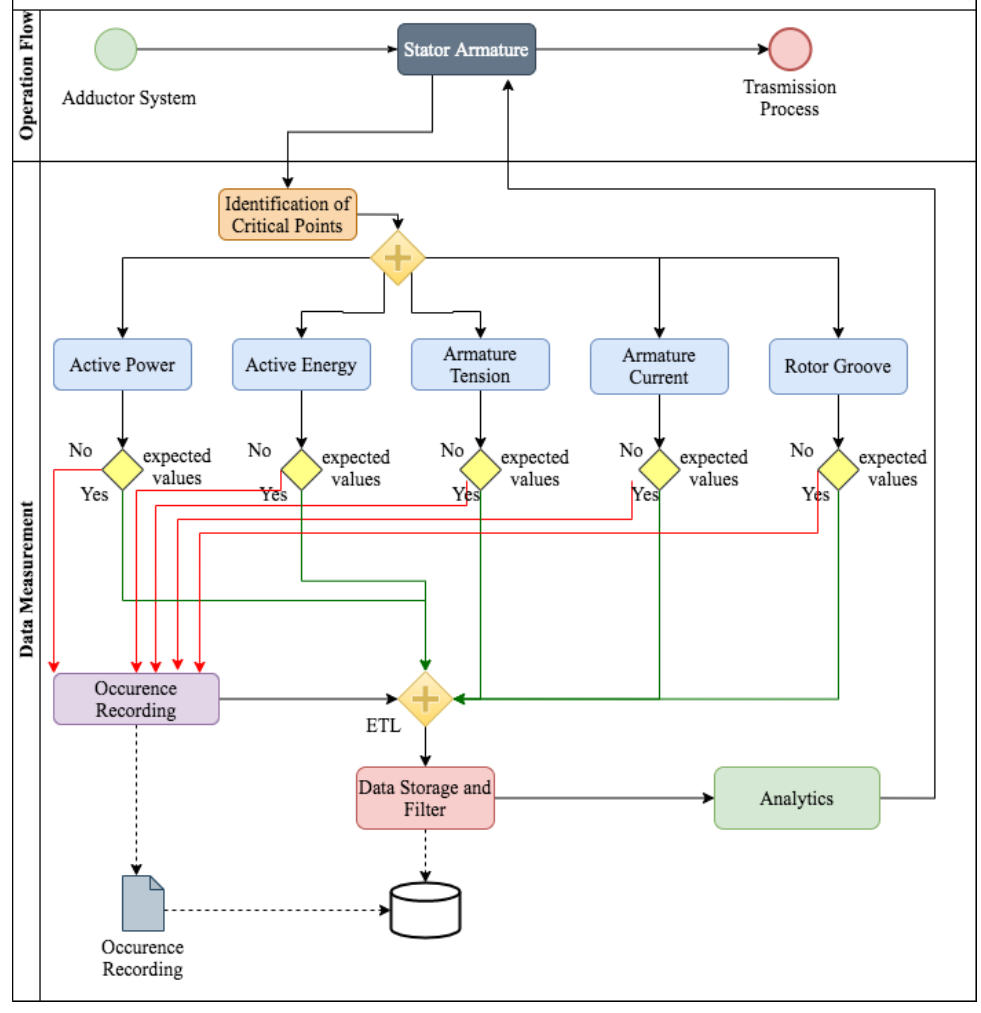
Figure 4. Mapping of the Component “Stator